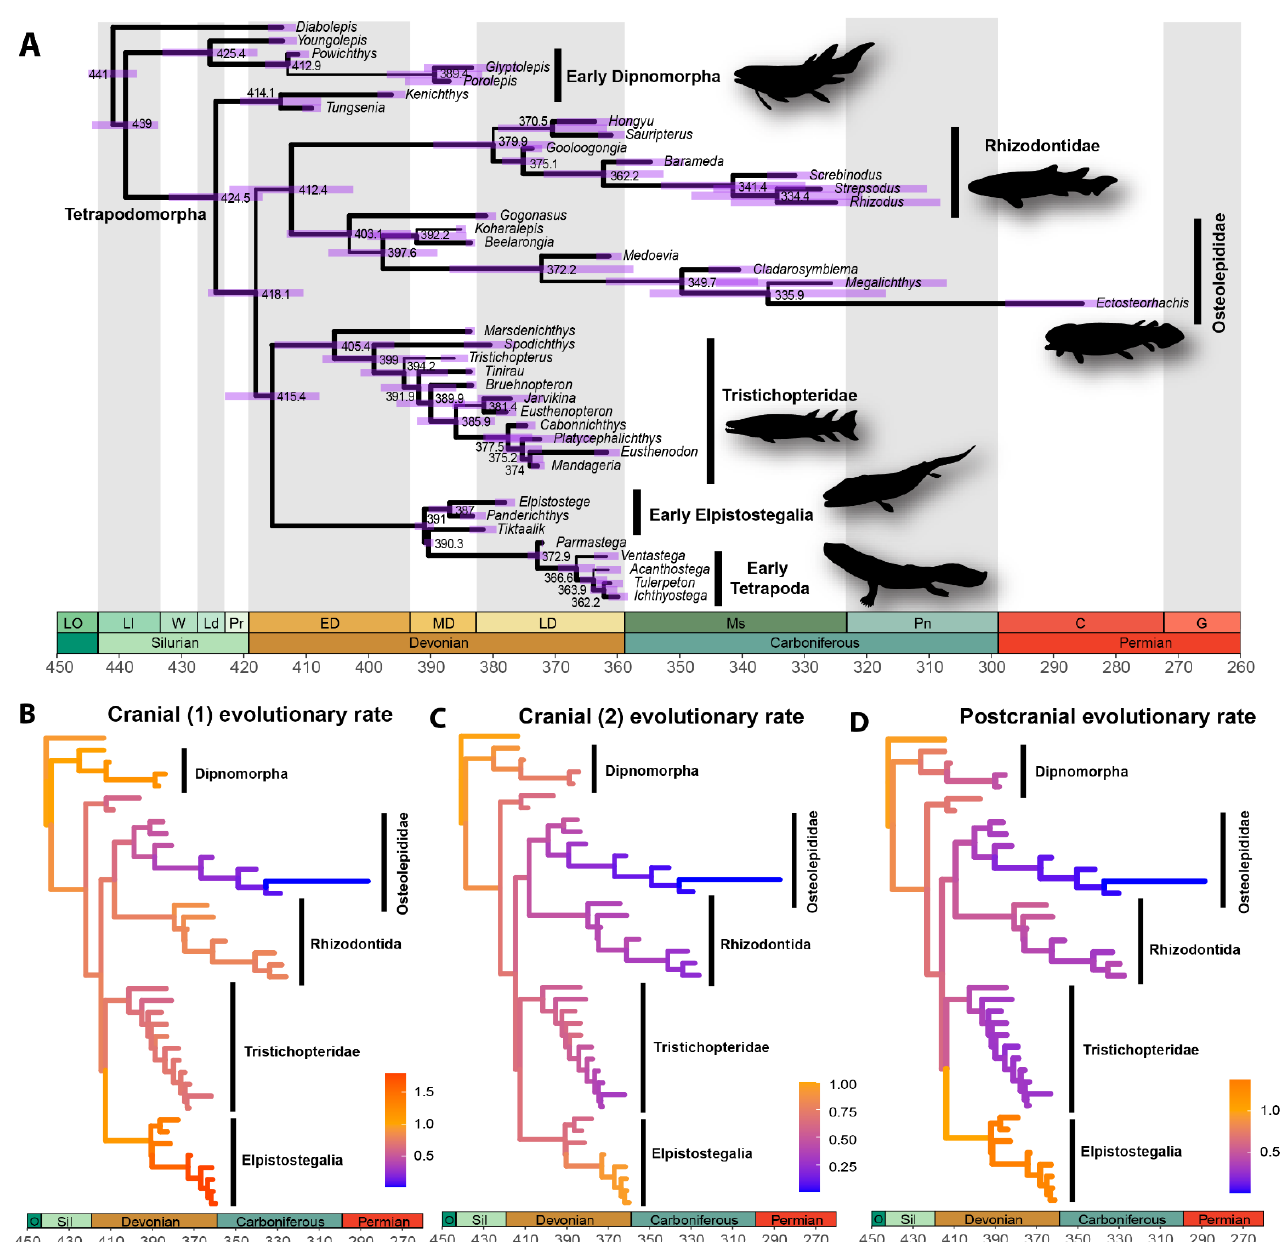
Figure 1. Bayesian evolutionary tree with estimated divergence times and evolutionary rates for the major groups of early tetrapodomorphs (adapted from [67]). ( A ) Divergence times for the fish – tetrapod transition. Node values represent median ages; purple error bars represent the 95% highest posterior density (HPD) intervals; branch thickness is proportional to posterior probabilities. ( B – D ) Relative rates of morphological evolution across subdivisions (partitions) of the phenotype in early tetrapodomorphs: two partitions including cranial characters and one partition including postcranial characters. All silhouettes created by TRS.